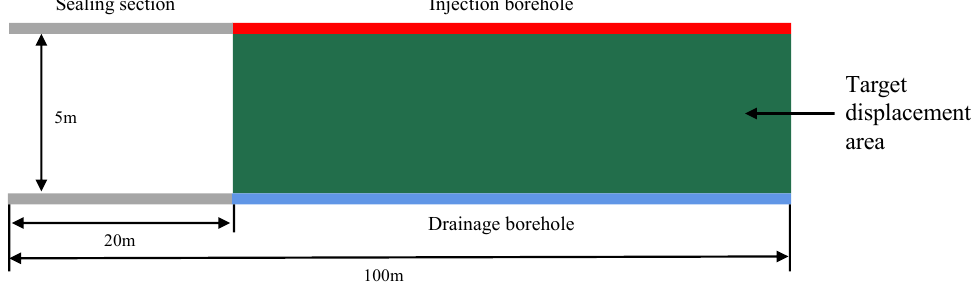
Figure 8. The schematic diagram of boreholes design. Table 2. Borehole design parameters.